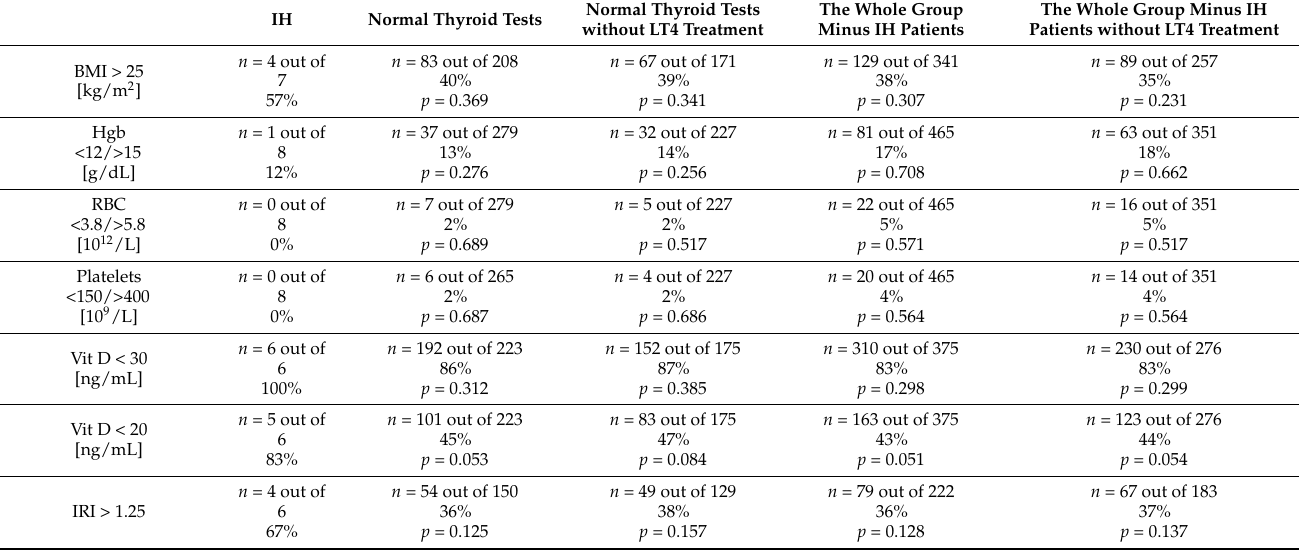
Table 5. Percentage of abnormal values of chosen parameters potentially associated with hypothyroxinemia in patients with isolated hypothyroxinemia (IH) vs. patients with normal thyroid tests (additionally after excluding individuals on L-thyroxine (LT4) treatment) and vs. the whole group of 466 inpatients minus patients with IH (additionally after excluding individuals on L-thyroxine (LT4) treatment). Normal Thyroid Tests Normal Thyroid Tests without LT4 Treatment The Whole Group Minus IH Patients The Whole Group Minus IH Patients without LT4 Treatment